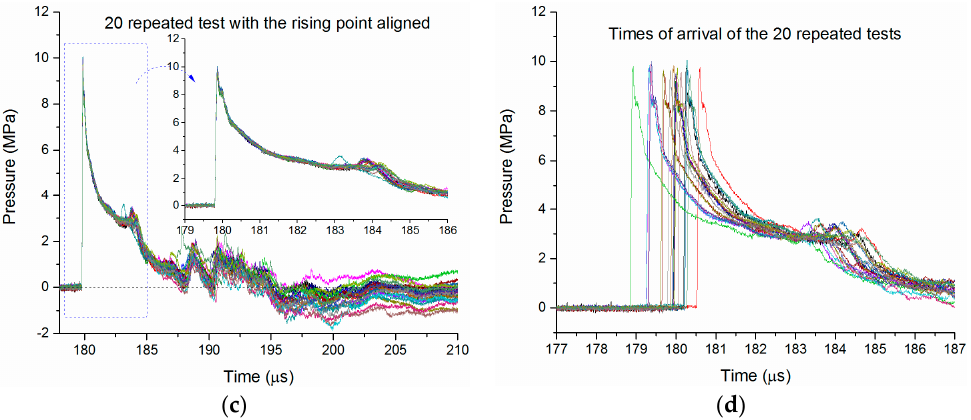
Figure 4. 20 repeated temporal pressure waveforms at the distance of 260 mm from discharge channel. ( a ) Pressure waveforms obtained by the PCB138 probe with the SW arrival times aligned; ( b ) distribution of the SW arrival times obtained by the PCB138 probe; ( c ) pressure waveforms obtained by the Müller-plate probe with the SW arrival times aligned; ( d ) distribution of the SW arrival times obtained by the Müller-plate probe.